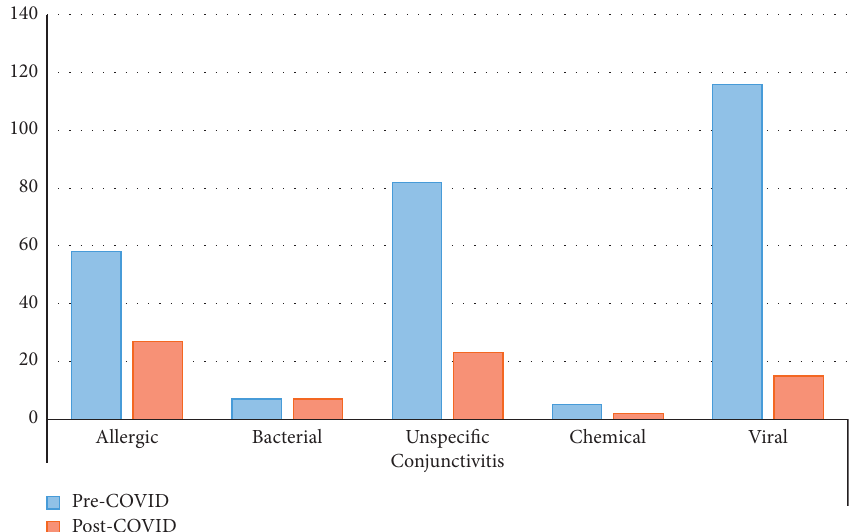
Figure 2: Distribution of patients attended with conjunctivitis at the emergency department during the pre-COVID-19 and post-COVID- 19